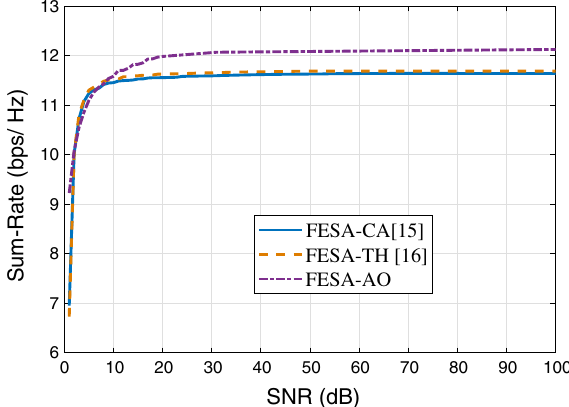
Fig. 7 Sum rate versus the number of iterations. We set N t = 60 , K = M = 12 , and SNR = 0 dB